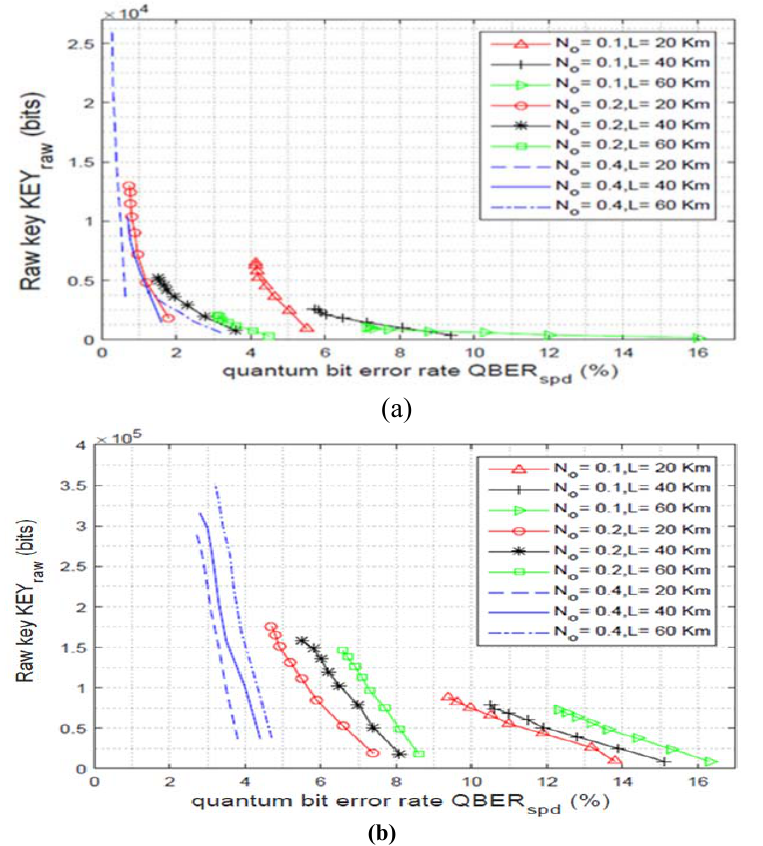
Fig. 12. KEYraw vs. QBERspd (%) at different L and N_0(a) λ=1550nm (OF) (b) λ=860nm